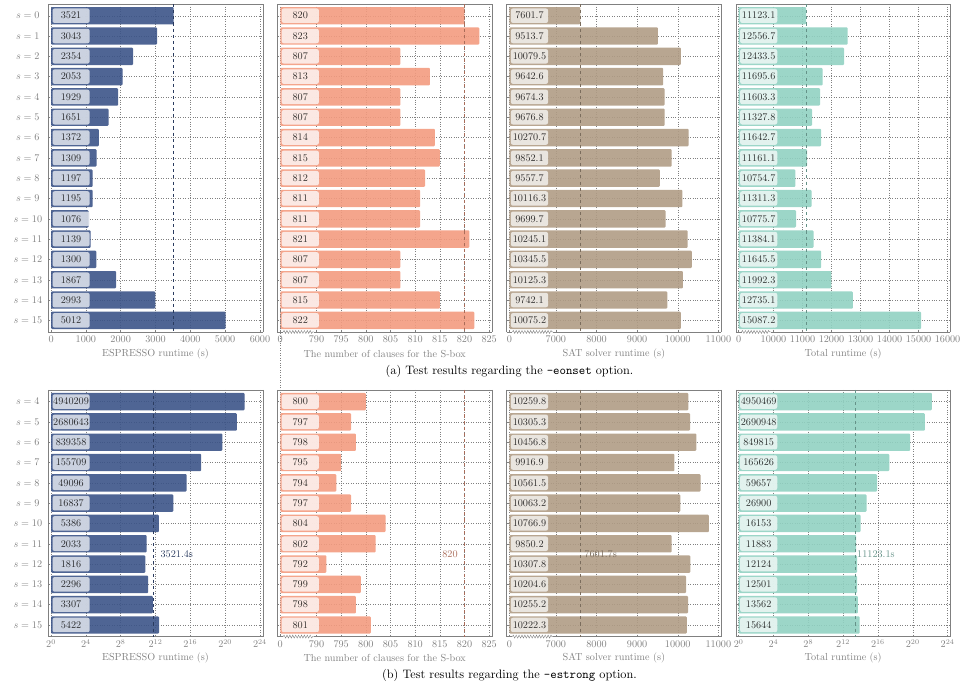
regarding S 8 . ⟨ 8 , 8 , 10 ⟩